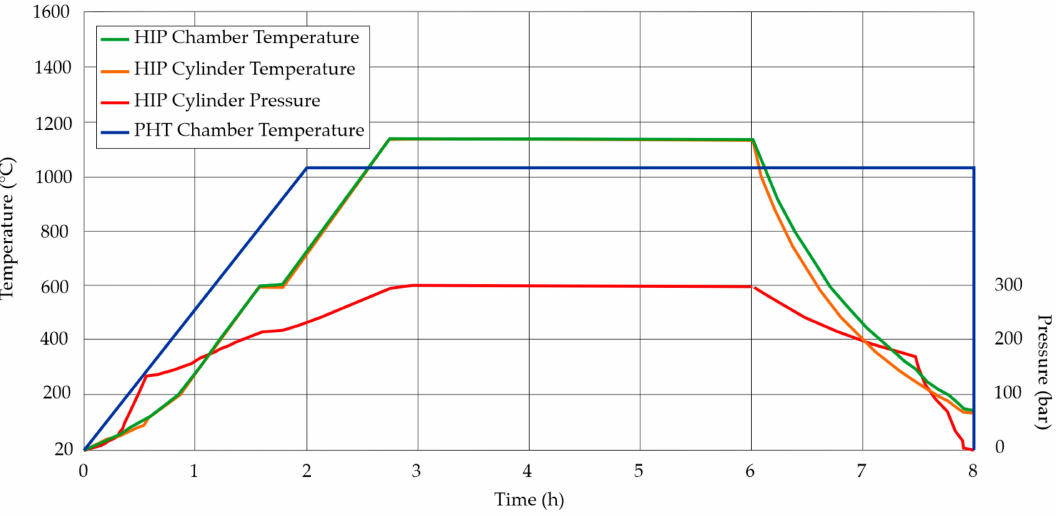
Figure 2. The course of heat treatment